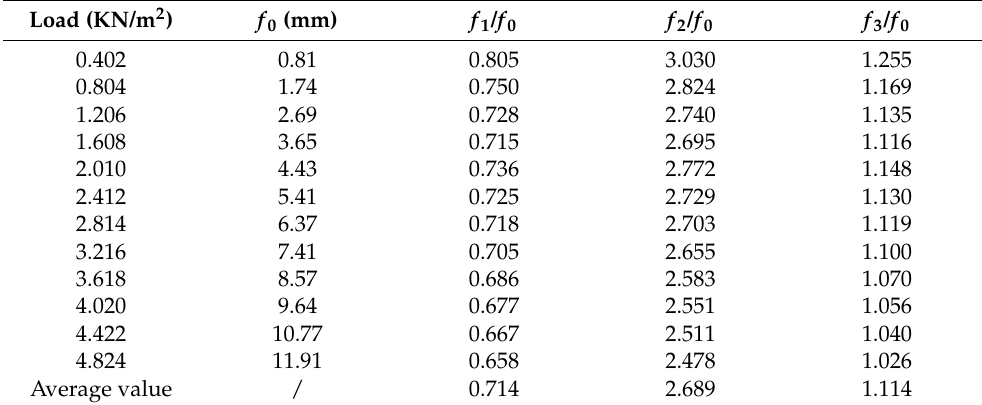
Table 8. Comparison of mid-span deflection of specimens.